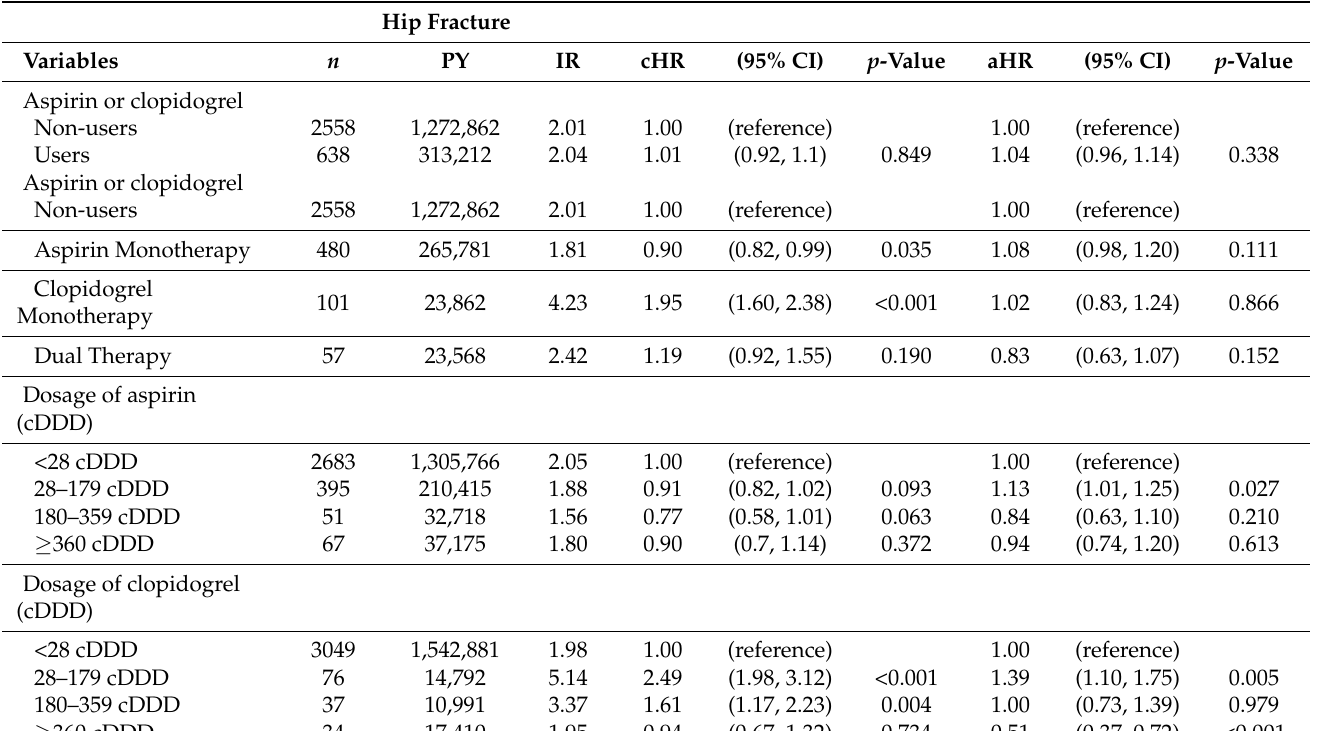
Table 2. Hazard ratio of hip fracture stratified by dosage and duration of antiplatelet agents. Hip